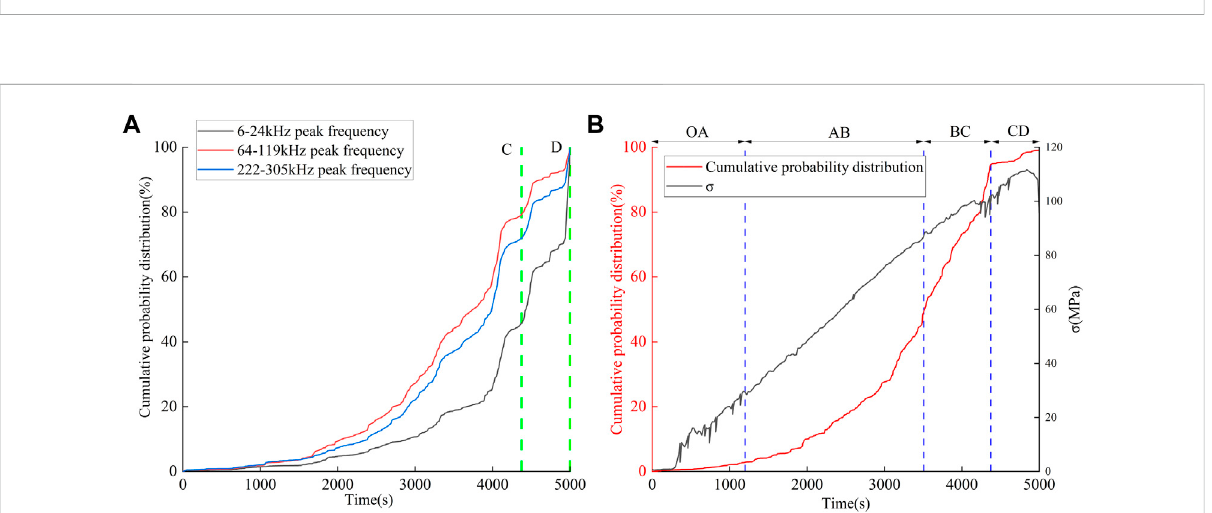
FIGURE 14 Statisticalresults for granite showing: (A) CPD curves of events withan initial frequencyof 1,000 kHzcombined withpeak frequenciesof6 – 24, 64 – 119, 222 – 305 and 625 kHz, and (B) FEs (625 kHz peak frequency& 1,000 kHz initial frequency) CPD and stress